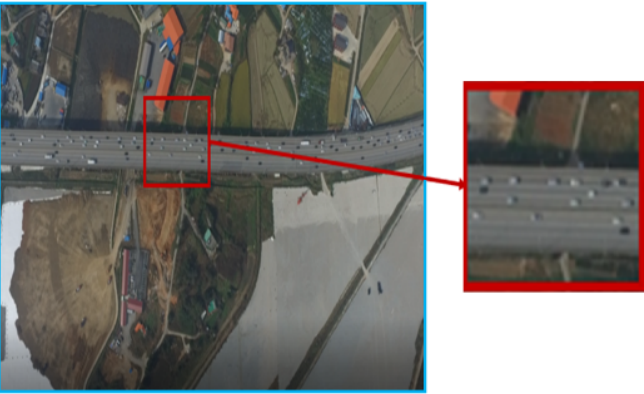
Figure 2. Example of UAV image used in the